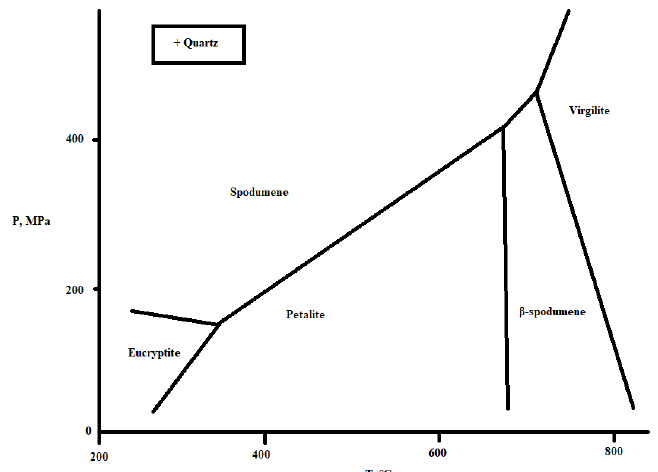
Figure 4. Stability relations among eucryptite (LiAlSiO 4 ), α-spodumene (LiAlSi 2 O 6 ), petalite